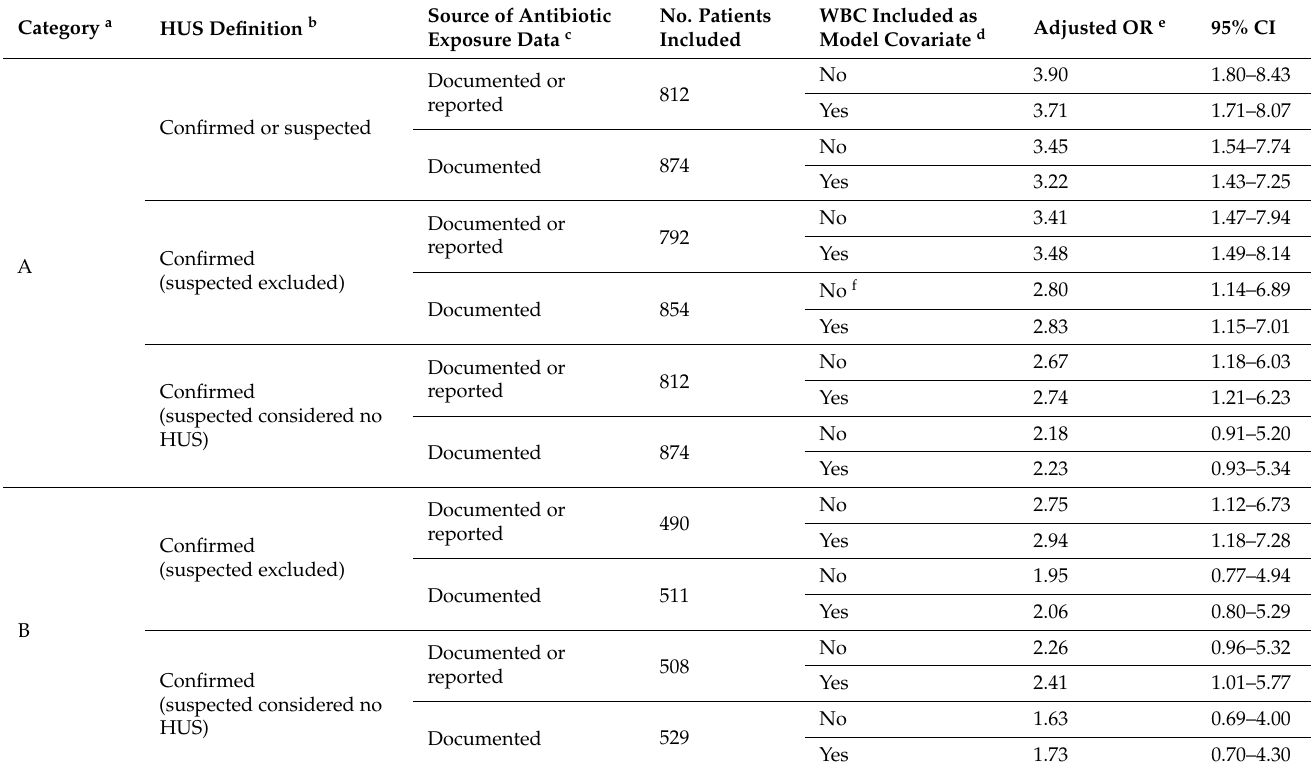
Table 6. Secondary models for the association between β -lactam treatment during the first 7 days of illness and development of